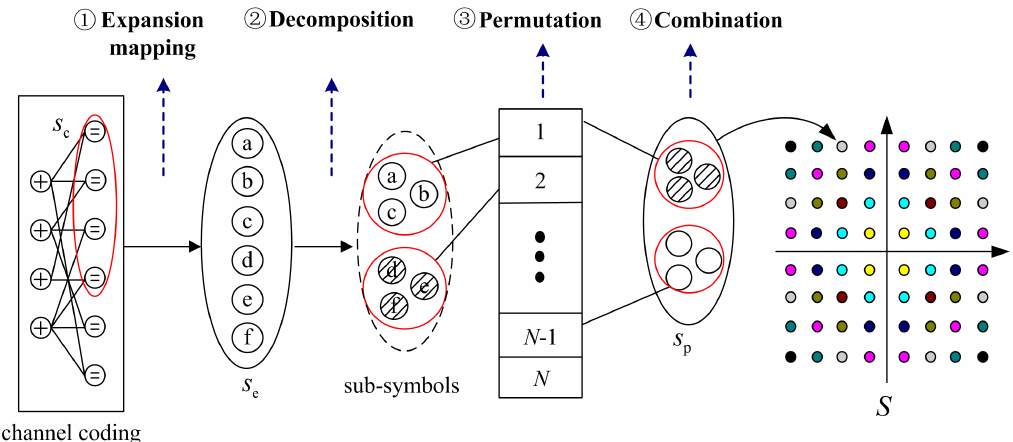
Figure 3. The process for generating nonequiprobable constellations.